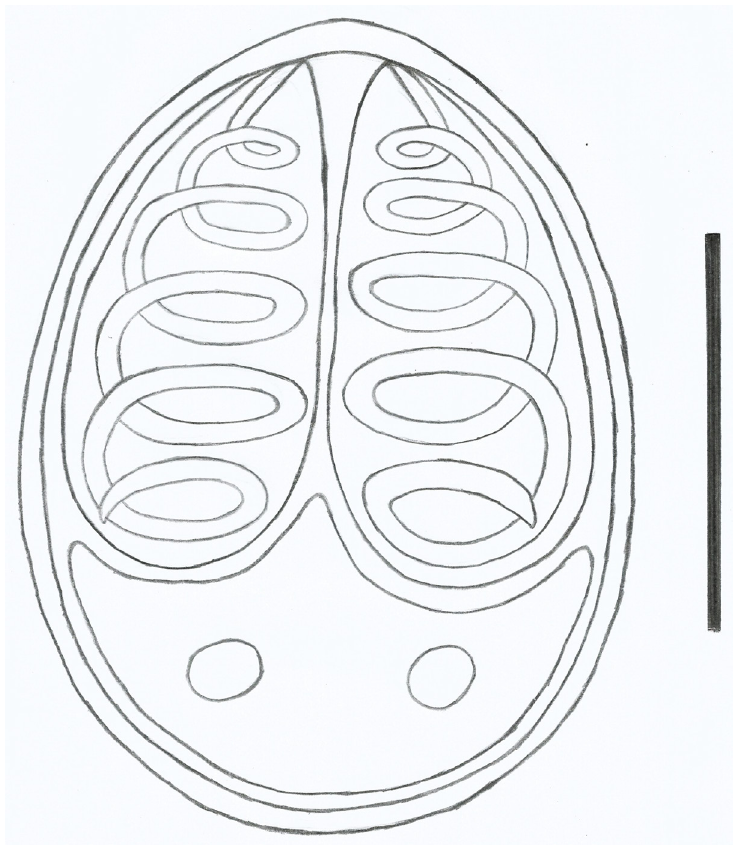
Fig. 3. Schematic representation of the mature myxospore Myxobolus adrianoi sp. nov., parasite of intestine of the Corydoras schwartzi Rössel, 1963. Scale bar: 10